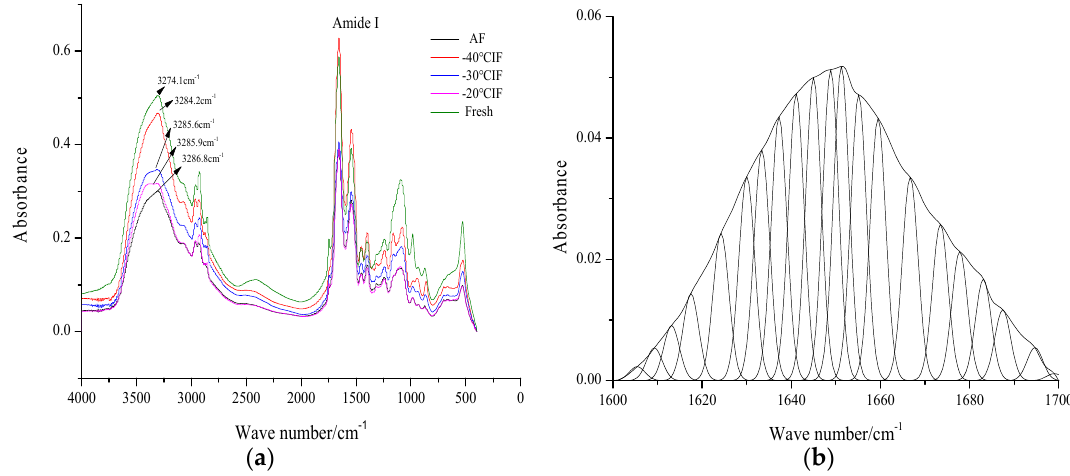
Figure 3. Fourier transform infrared spectroscopy (FT-IR) spectra of snakehead blocks treated under di ff erent freezing conditions: ( a ) FT-IR spectrum of myofibrillar protein; ( b ) deconvoluted infrared amide I band of the fresh sample.